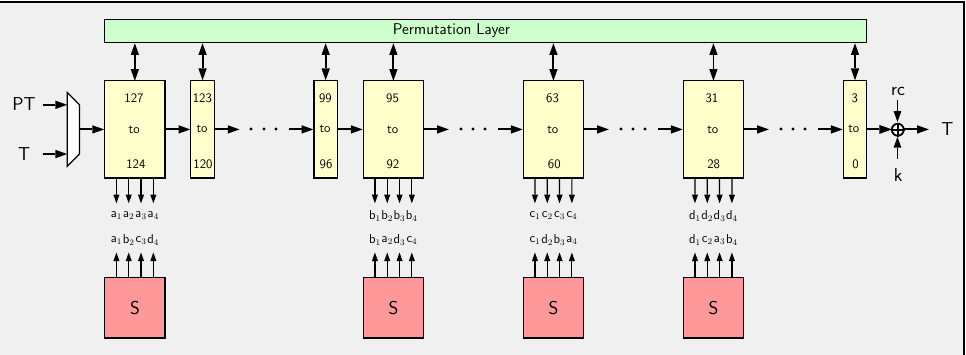
Figure 8: 4-bit GIFT ∗ state pipeline. Registers are marked in